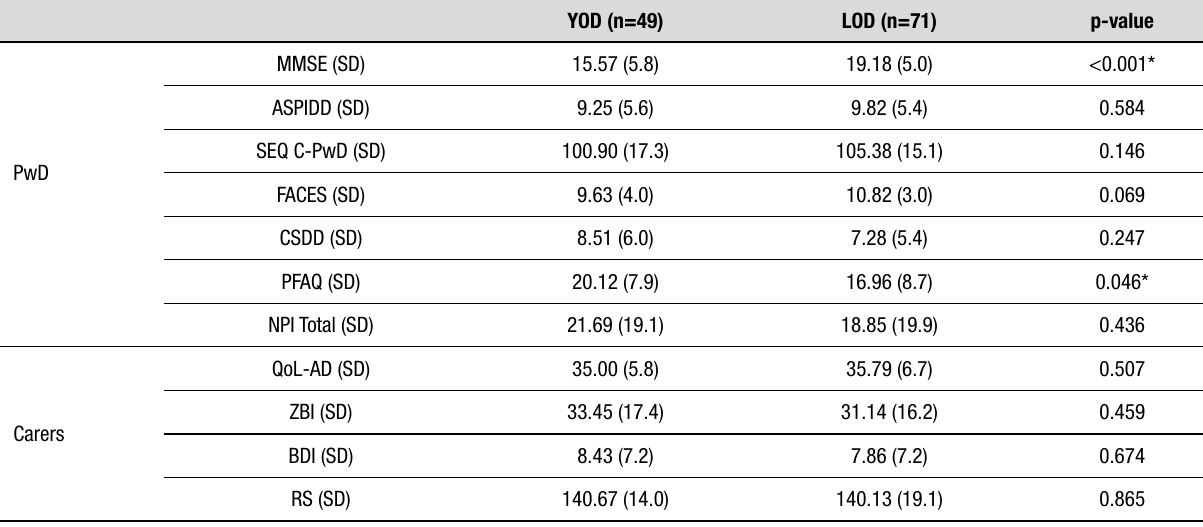
Table 2. Clinical characteristics of people with dementia and carers according to age of